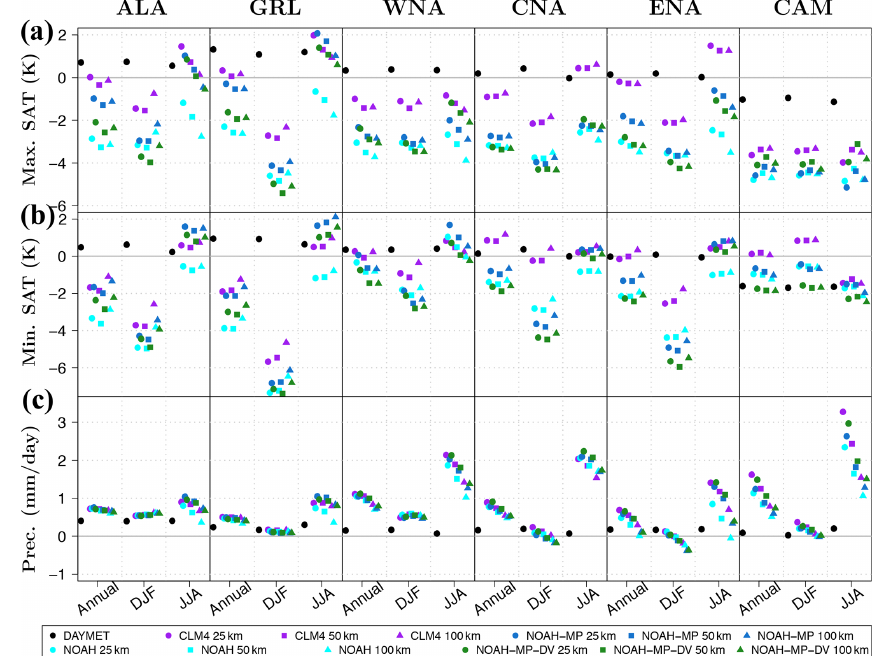
Figure 9. Regional mean annual and seasonal biases in maximum and minimum temperatures ( ◦ C) and in accumulated precipitation (mmd − 1 ) for all experiments and the DAYMET data product relative to the CRU database from 1980 to 2013. Biases are estimated av- eraging over six subregions (Fig. 1) adapted from Giorgi and Francisco (2000): Central America, CAM; western North America, WNA; central North America, CNA; eastern North America, ENA; Alaska, ALA; and Greenland,